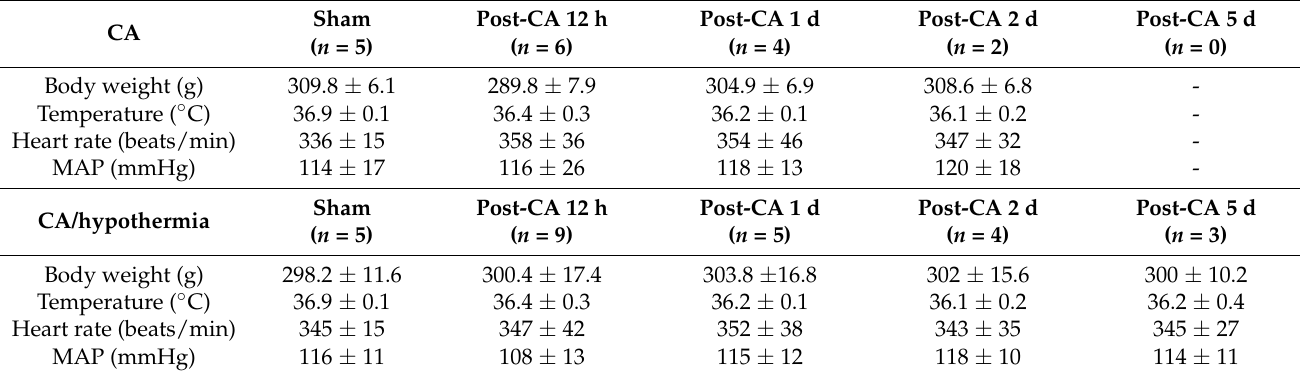
Table 2. Physiological variables in the sham, CA and CA/hypothermia